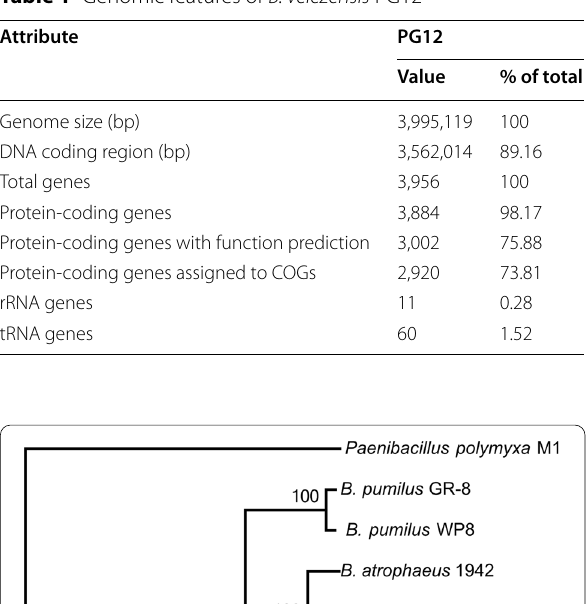
Table 1 Genomic features of B. velezensis PG12